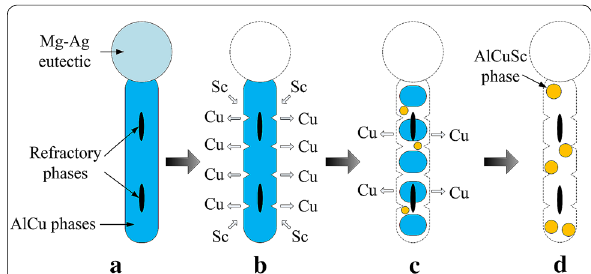
Figure 5 Schematic diagram of microstructure evolution in homogenization process (Modification and redrawing based on the figure in Ref. [38]): a As-cast microstructure, b Low melting eutectic phase dissolve completely and AlCu phase dissolve partly, c AlCu phase further dissolve and a new phase containing Sc form, d Refractory phase and the new AlCuSc phase remain after homogenization